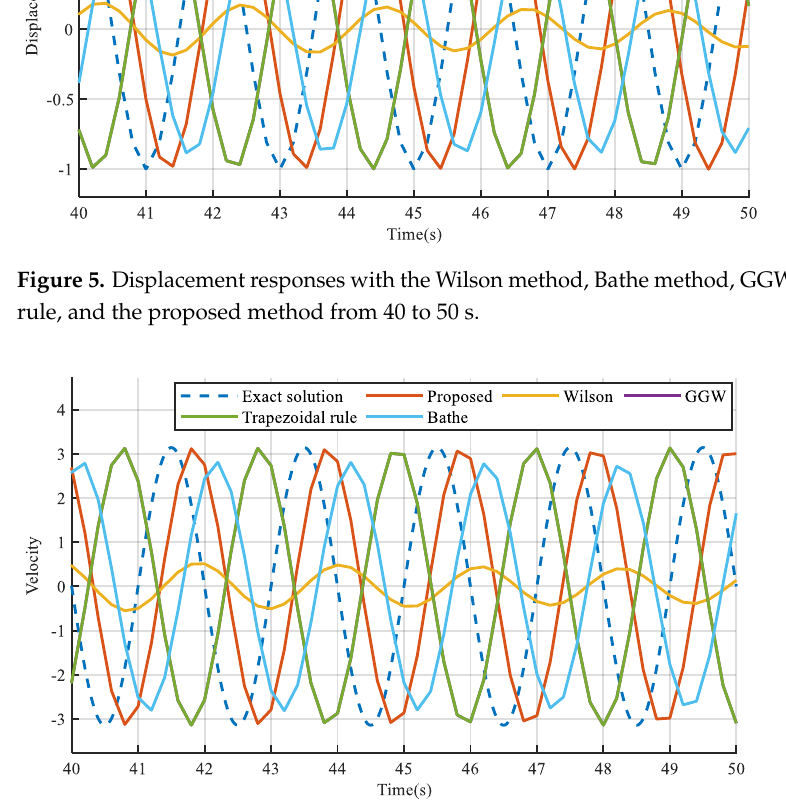
Figure 6. Velocity responses with the Wilson method, Bathe method, GGW method, trapezoidal rule, and the proposed method from 40 to 50 s.